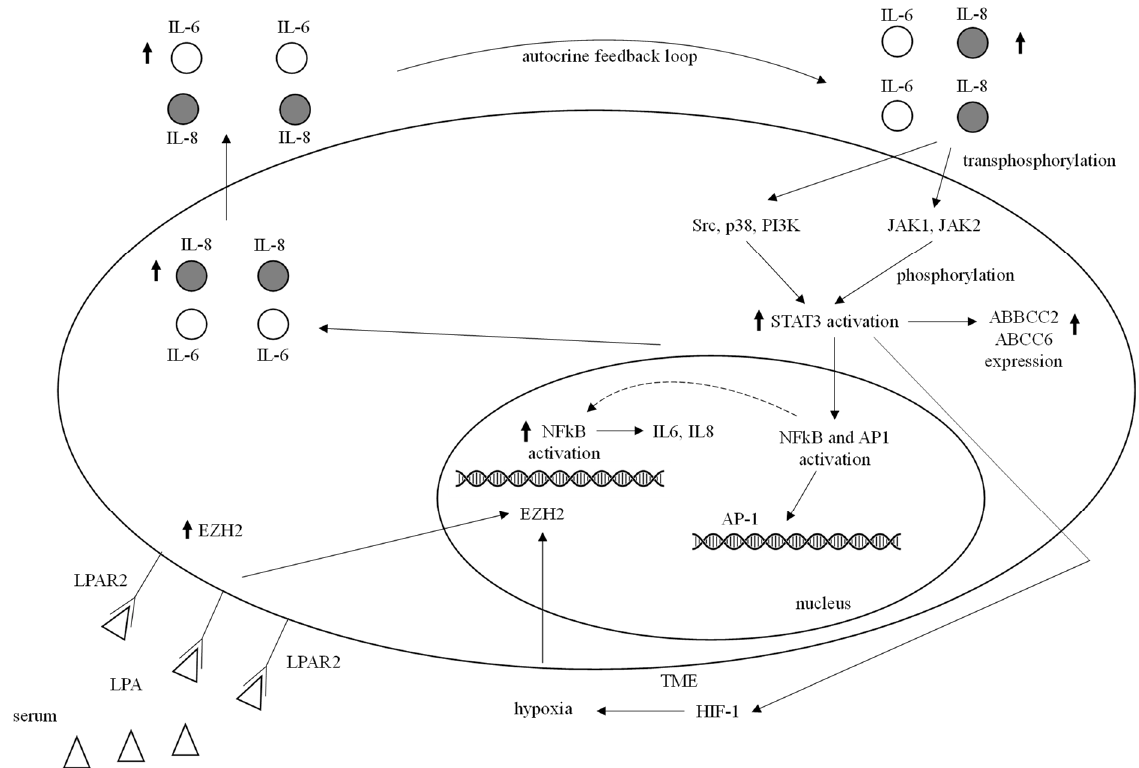
Figure 3. NFkB and JAK/STAT pathways. Potential mechanisms of chemotherapy resistance (ctr) in TNBC. NFkB is upregulated by hypoxia and activated through LPA-LPAR-EZH2-NFkB signaling cascade which results in autocrine production of IL-6 and IL-8. Extracellular IL-6, IL-8 ligand permits transphosphorylation of JAKs that successively phosphorylate STAT monomers. Activated STAT3 enters nucleus, where it governs transcription of many target genes; activated STAT3 also induces upregulation of ABCC2 and ABCC6, and therefore IL-6 and IL-8 by multiple pathways induce tumor growth, resistance to apoptosis, and chemotherapy resistance. LPA: lysophosphatidic acid; LPAR: LPA receptor; EZH2: enhancer of zeste homolog 2 (a gene component of polycomb repressive complex (PRC2) and epigenetic regulator); TME: tumor microenvironment; IL: interleukin; NFkB: nuclear factor kappa-high chain enhancer of activated B cells; STAT: signal transducer and activator of transcription; Src: Src family kinase; p38: p38 mytogen-activated protein kinase; PI3K: phosphatidylinositol 3 kinase. ↑ increase. Also see text.